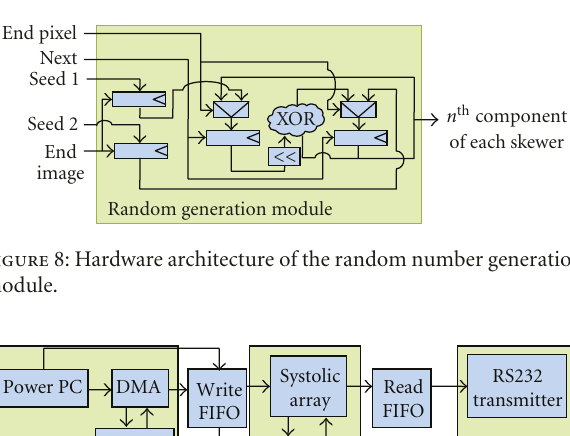
of N spectral values, just like a skewer. A dot-product calculation between a pixel f i and a skewer j can be simply obtained by using the expression